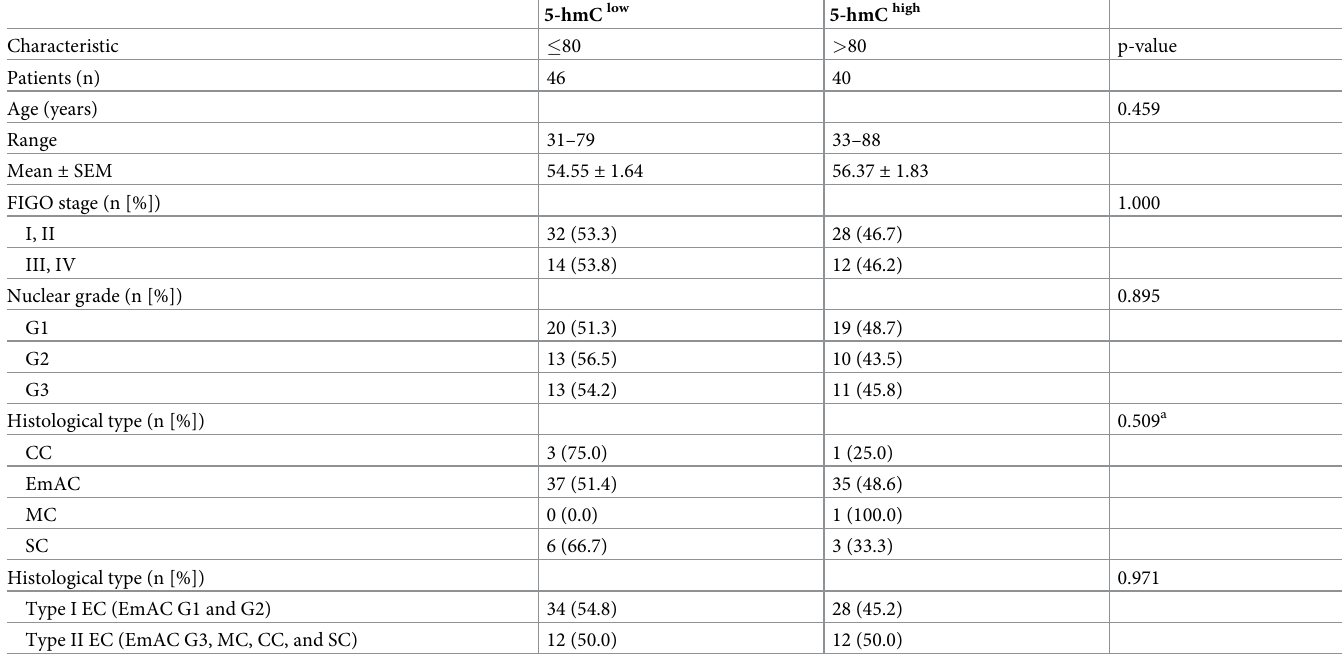
Table 4. Association of 5-hmC expression score with clinicopathological features in